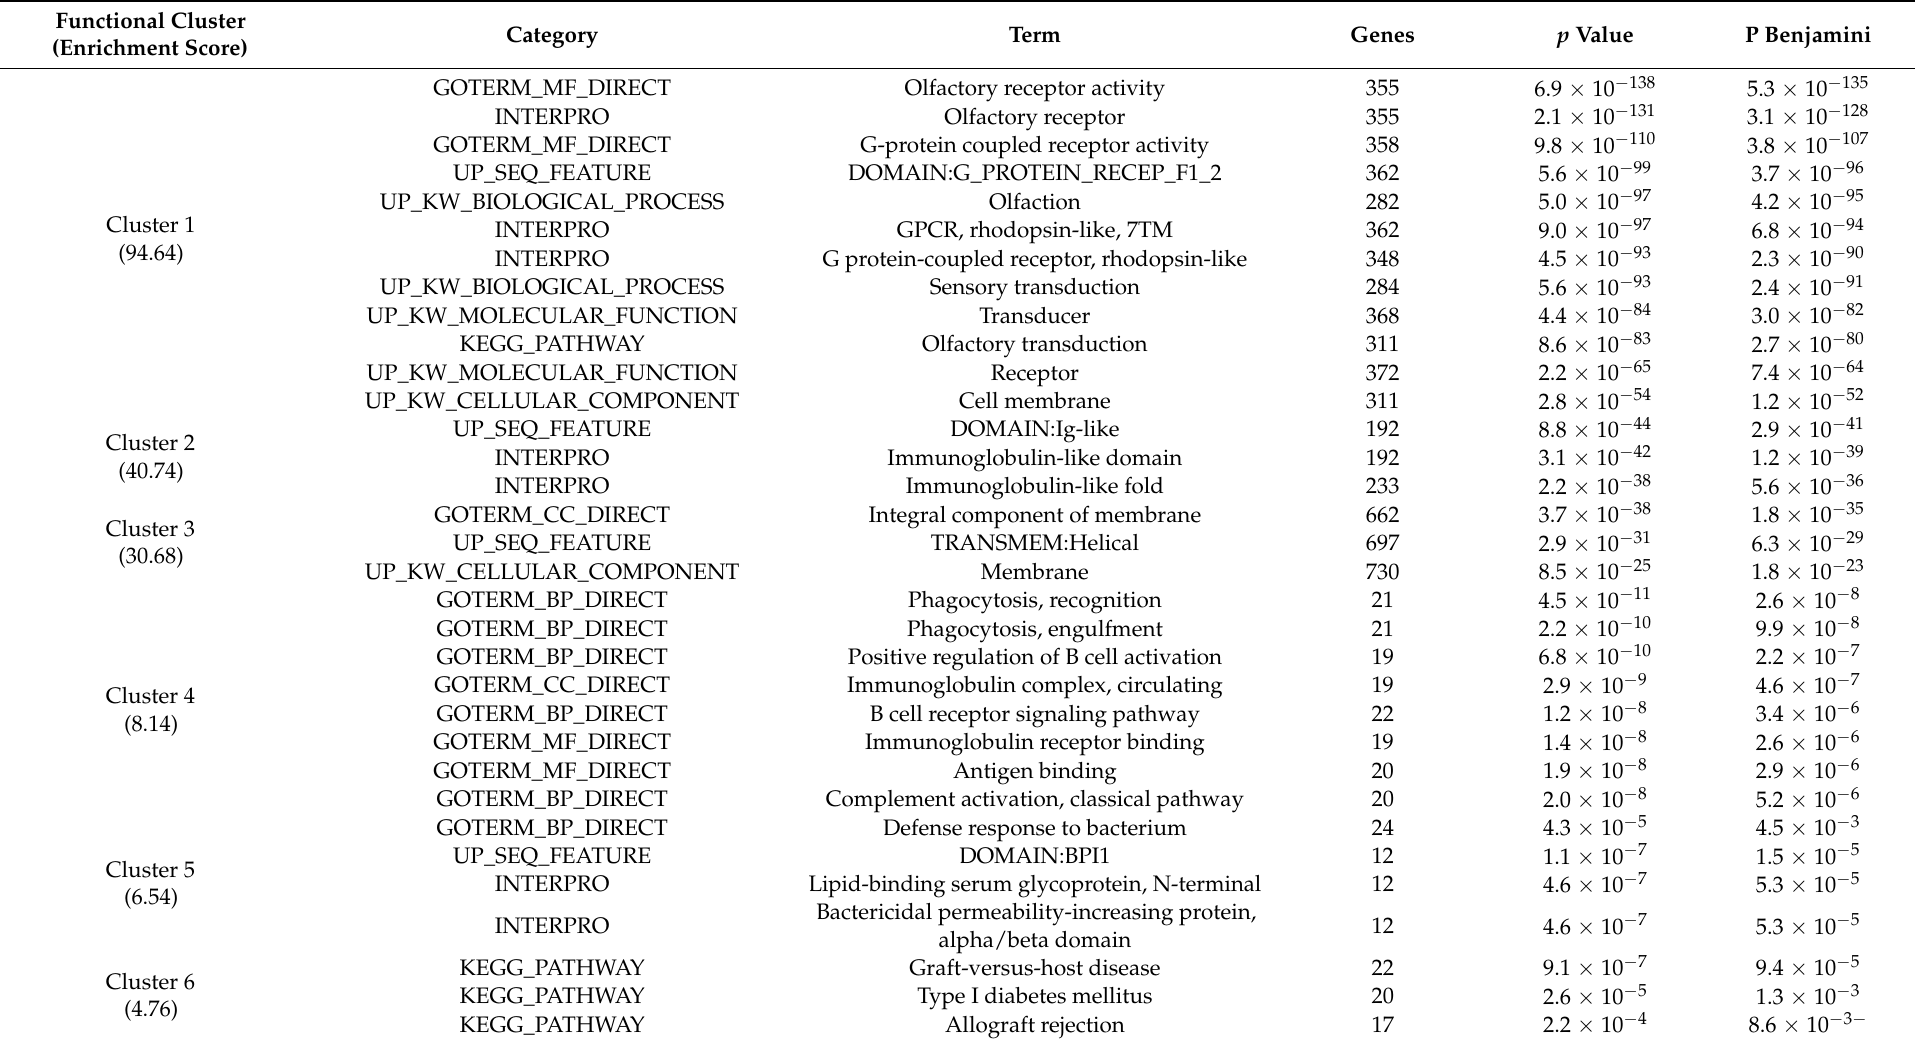
Table 3. Significantly enriched annotation clusters and functional